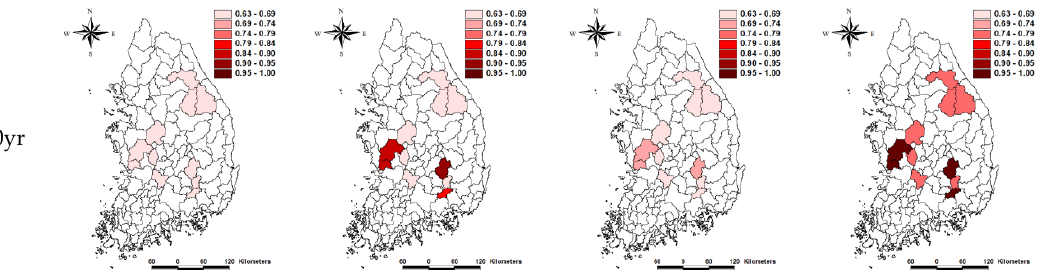
Figure 6. Flood risk map according to representative concentration pathway (RCP) 8.5 scenario.